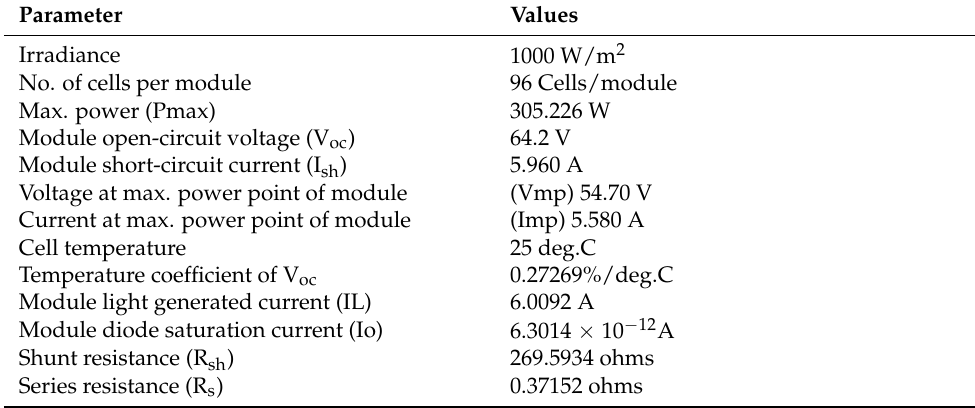
Table 3. SunPower SPR305-WHT-D manufacturer data for the PV system.